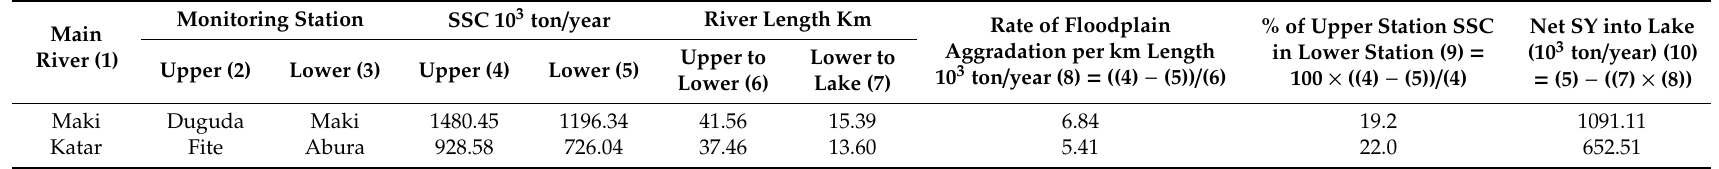
Table 4. Sediment flux rates of the tributary